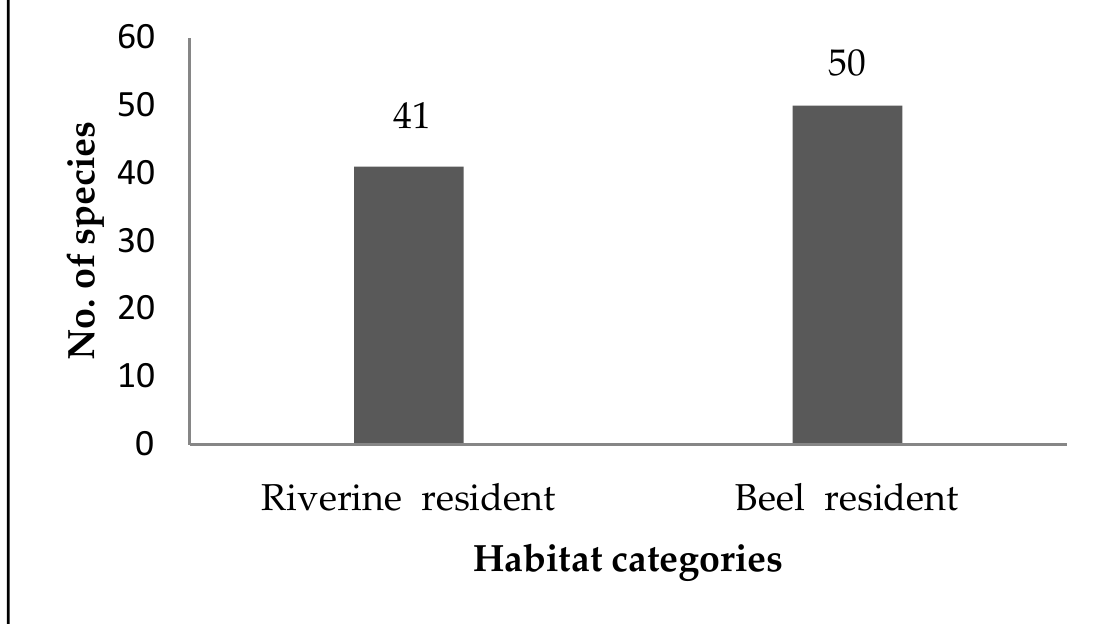
Figure 5. Habitat preference of the freshwater fishes in the study area.